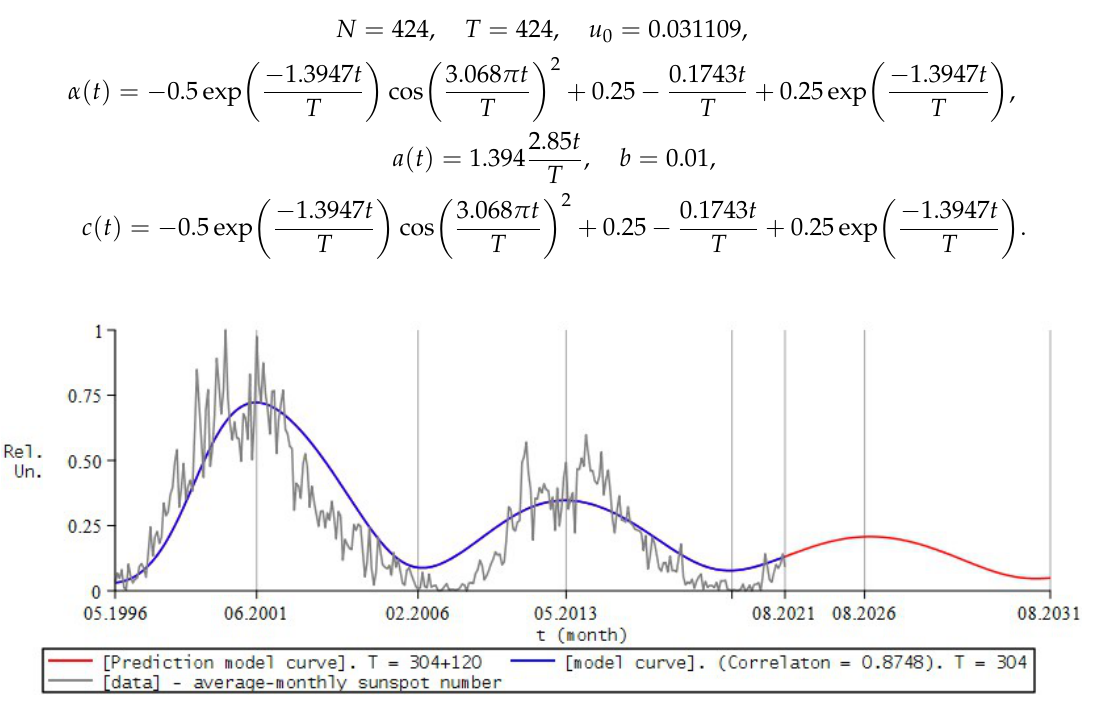
Figure 10. Numerical experiment for SA. Correlation coefficient